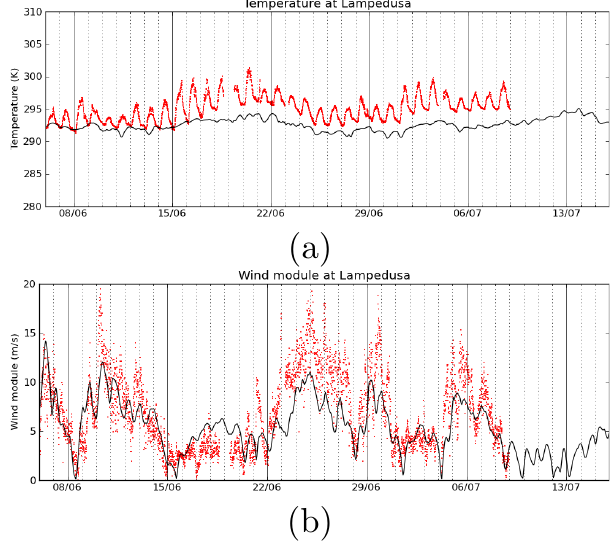
Figure 1. (a) Modelled temperature at Lampedusa (K, black line) and measured temperature (red points); (b) same as (a) but for the module of the wind at Lampedusa (ms − 1